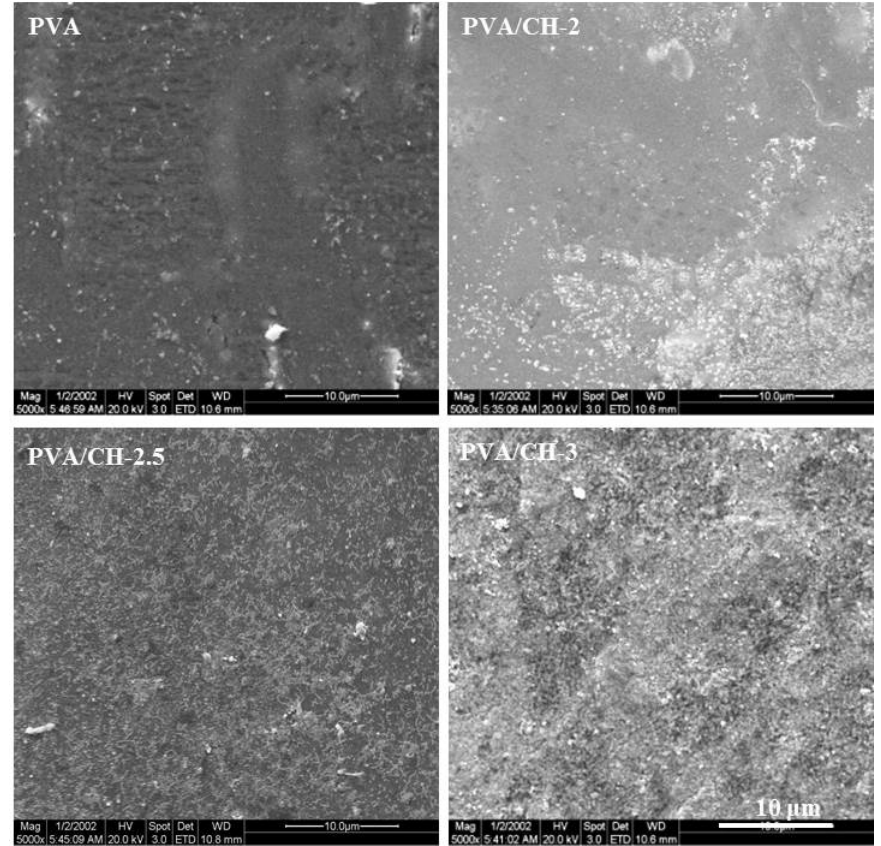
Figure 1. Scanning electron microscopy (SEM) morphologies of pure Poly(vinylalcohol) (PVA) film and different PVA/CH films.